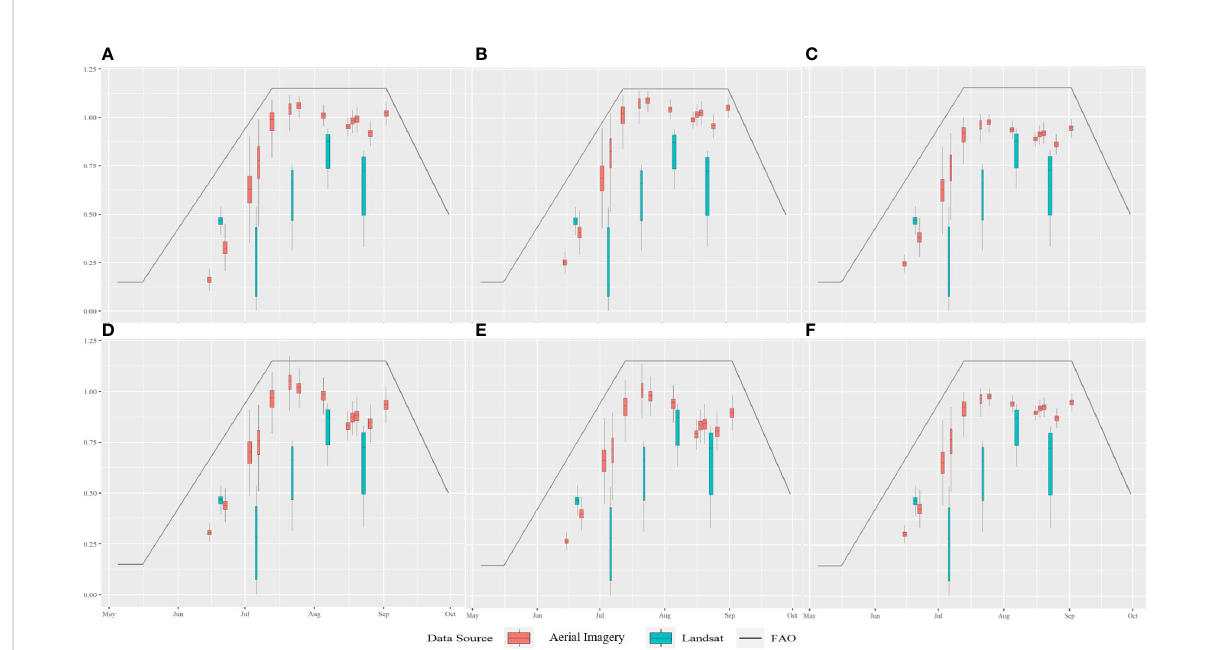
FIGURE 5 Total seasonal differences between the Aerial Imaging crop coef fi cients and the Landsat Fractional ET Data at Field (B) Aerial Imaging crop coef fi cients were estimated from equations developed by (A) Kamble et al. (2013), (B) Bausch and Neale (1987), (C) Bausch and Neale (1987), (D) Bausch (1993), (E) Campos et al. (2017), and (F) Neale et al., (1989).